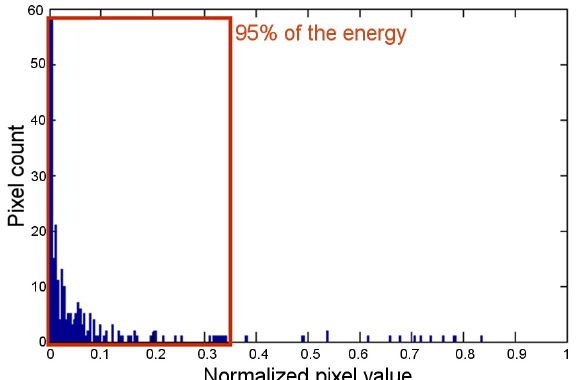
Figure 9. Histogram of channel R of the cropped image with LED1 turned on in red color; the distance between emitter and receiver was set to 100